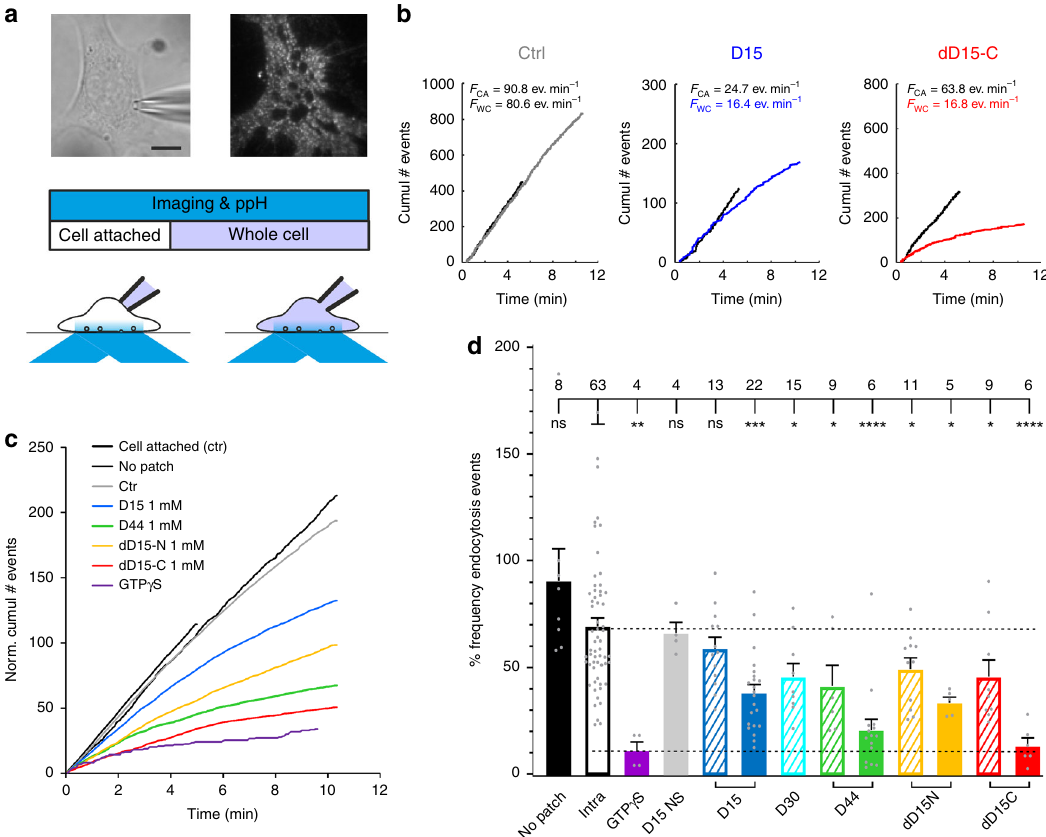
Fig. 5 Effect of D15-based peptides on CME monitored with the ppH assay. a Experimental design. Top, images of a 3T3 cell recorded with a patch-clamp electrode (seen on the transmitted light image, left) and transfected with TfR-SEP imaged with TIRF microscopy (right). The cells are recorded for at least 15 min with the ppH assay. In the fi rst 5 min, the cell is in the cell attached con fi guration (left) and in the last 10 min in the whole cell con fi guration (right). Scale bar 5 µ m. b Examples of recordings of cells with internal solutions containing no peptide (Ctrl, left), 1 mM D15 (middle) or 1 mM dD15-C (right). Black lines represent the cumulative number of detected endocytosis events over time in cell attached con fi guration. They are all straight lines, indicating that the event frequency remains constant during recording. This frequency F CA is written on top of the graph. Lines in colour represent the cumulative number of events in whole cell con fi guration. Note that at early time points these curves are tangential to the corresponding curves in cell attached, indicating the same endocytosis activity. In the example with the control solution, the slope of this curve remains constant with only a slight de fl ection towards the end of the recording. On the other hand, the de fl ections are much more marked with solution containing inhibitory peptides. The frequency F WC in the last two minutes of the whole cell recording is indicated on top of the graphs. c Averages of curves normalized to the corresponding cell attached recordings and displayed as in (b) for all the conditions tested in this study. d Average ± SEM of the ratio of event frequency measured 8 – 10 min in whole cell over event frequency 3 – 5 min in cell attached for the same cell. The number of recordings for each condition is indicated on top of the graph, and each individual measure is indicated by a grey circle. Recording solutions contain 100 µ M (hatched bars) or 1 mM (plain bars) of the indicated peptide. Stars